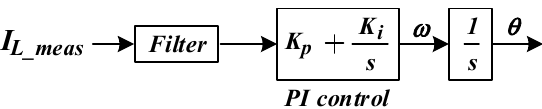
Figure 11. Phase lock loop (PLL) conceptual PI control block.